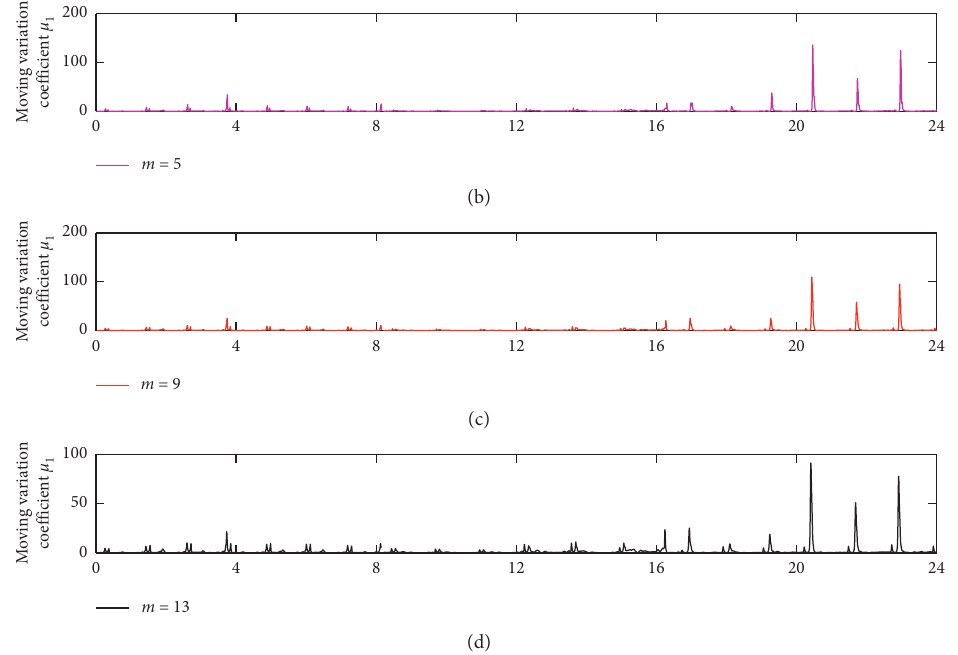
Figure 10: Calculation results of ECG signals under different window lengths.